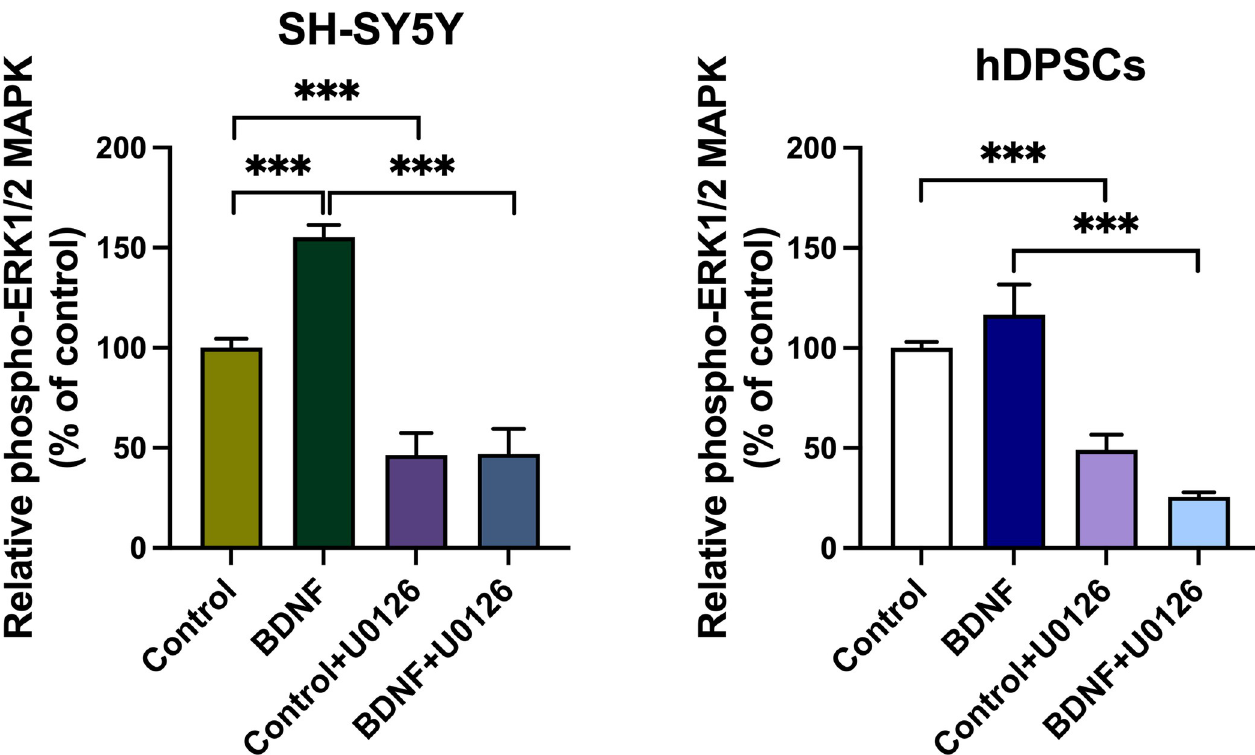
Fig 7. Analysis of p44/42 MAPK (ERK1/2) phosphorylation in neuronal differentiated SH-SY5Y and hDPSCs in the presence or absence of the ERK/ MEK inhibitor (U0126). These data were determined by quantitative sandwich ELISA and the absorbance values were read at 450nm. The data were analyzed by One-way ANOVA and Games-Howell Post-Hoc for pairwise comparison between the experimental groups. Data plotted as mean ± SD (n = 4; � P < 0.05, �� P < 0.01, and ��� P < 0.001).